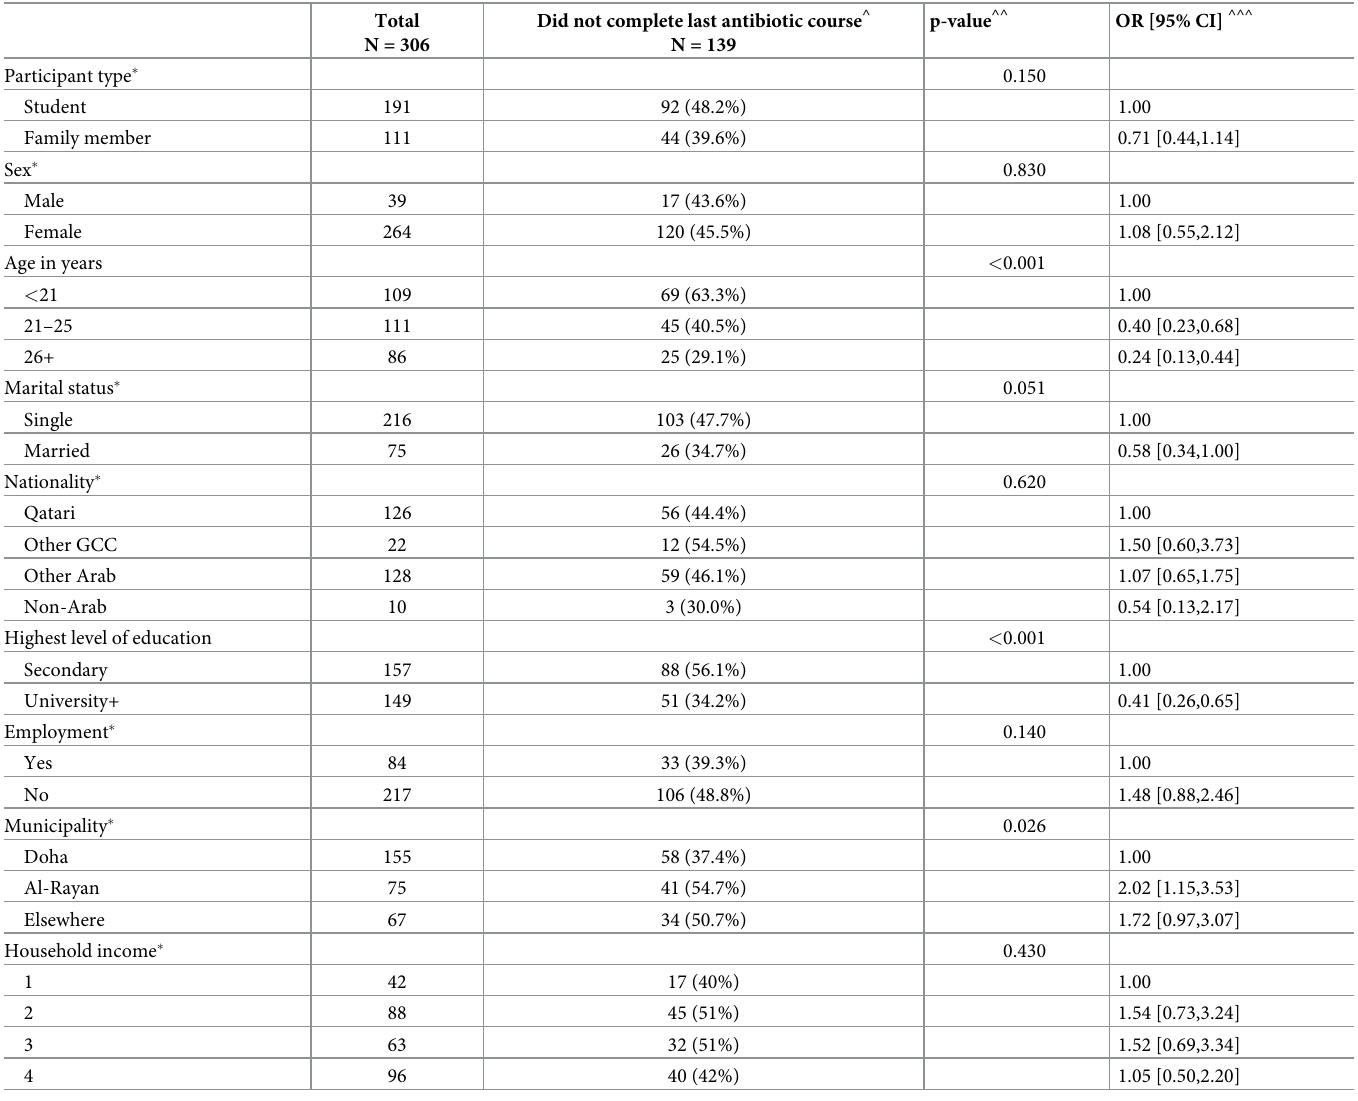
Table 4. Association between respondents’ characteristics and not completing the antibiotic